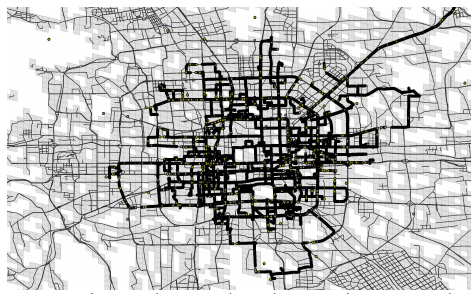
Figure 5. Major road network and one trajectory on the 14 th level